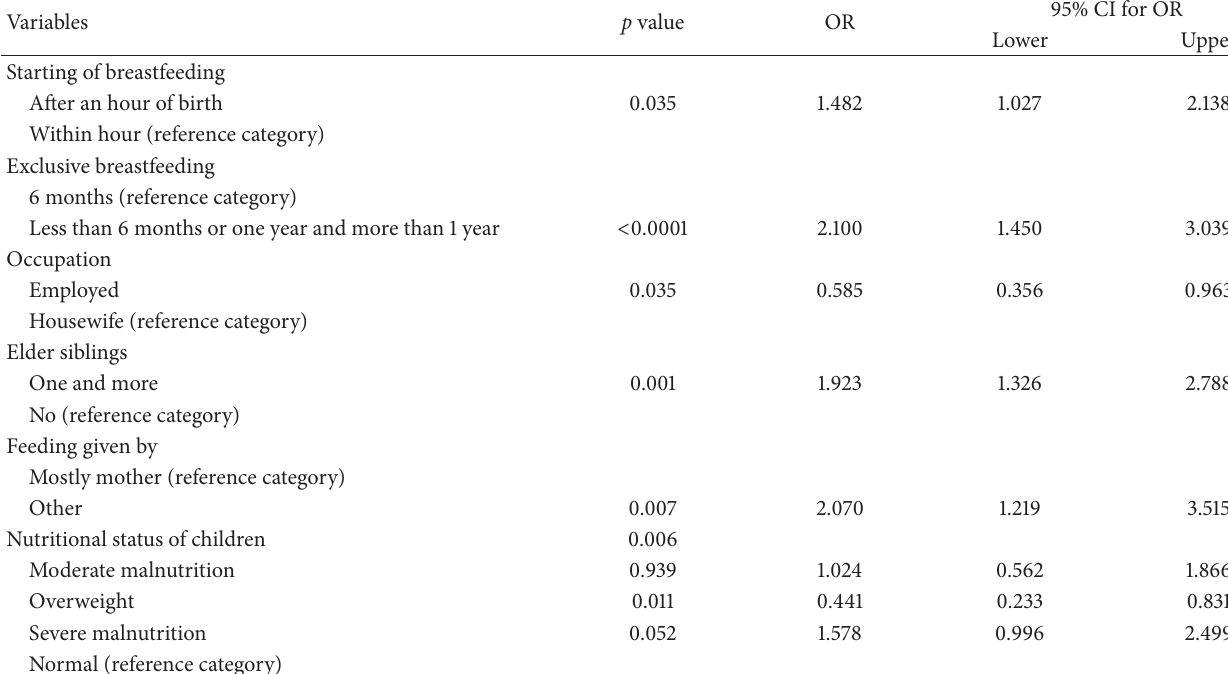
Table 4: Variables associated with hospital admissions in children aged more than 6